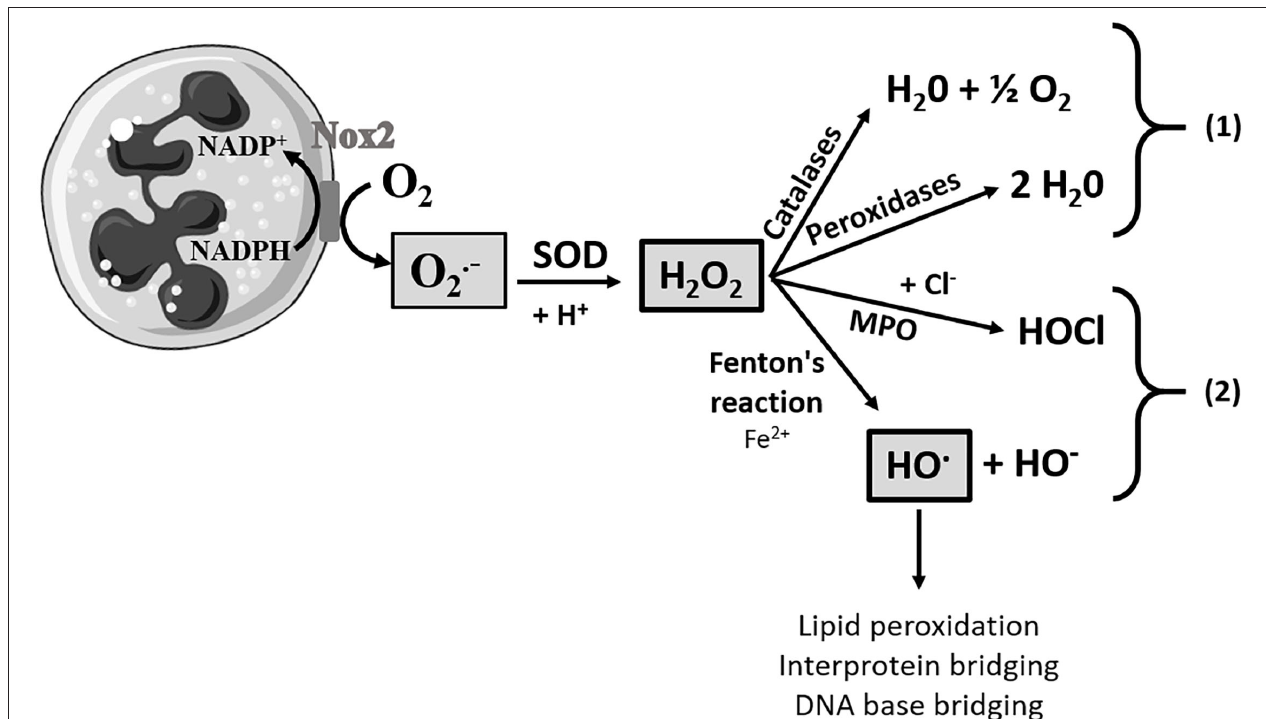
FIGURE 1 | Pathways of formation of reactive oxygen species. Here is a neutrophilic polynuclear cell and an oxidative cascade. A large amount of the superoxide anion will be produced by the action of NADPH oxidase (Nox2). The production of the superoxide anion will be regulated by a detoxification enzyme, superoxide dismutase (SOD), and thus will be dismuted into hydrogen peroxide (H 2 O 2 ). H 2 O 2 can be protected by the antioxidant system composed of catalases and peroxidase, pathway (1). However, when this molecule is present in a too large quantity, the antioxidant system will be overwhelmed and the hydrogen peroxide will either be transformed into hypochlorous acid (HOCl) by myeloperoxidase (MPO) or it will be transformed into the hydroxyl radical (HO . ), in the presence of Fe 2 + by the Fenton reaction, pathway (2). HO . is at the origin of lipid peroxidation, interprotein bridging, and DNA base bridging, and it is thus an extremely reactive and deleterious species for the tissues and